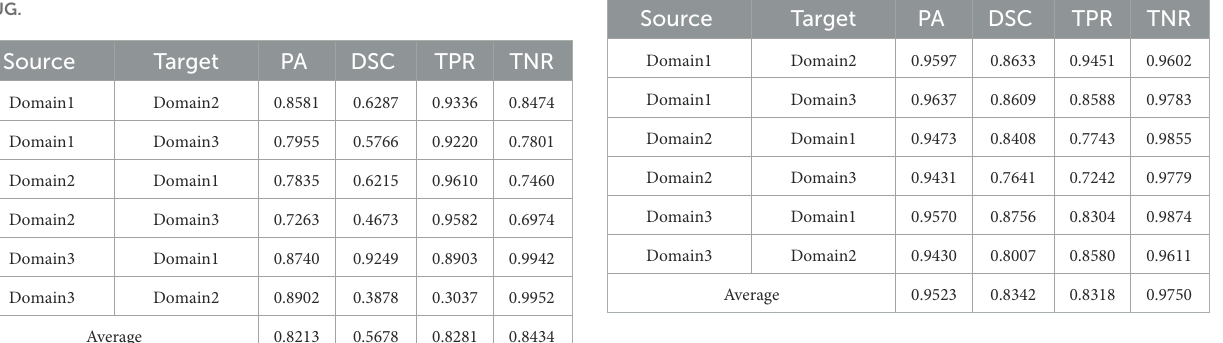
TABLE 2 Results on ultrasound thyroid nodule datasets with PSPNet (42) +AUG.